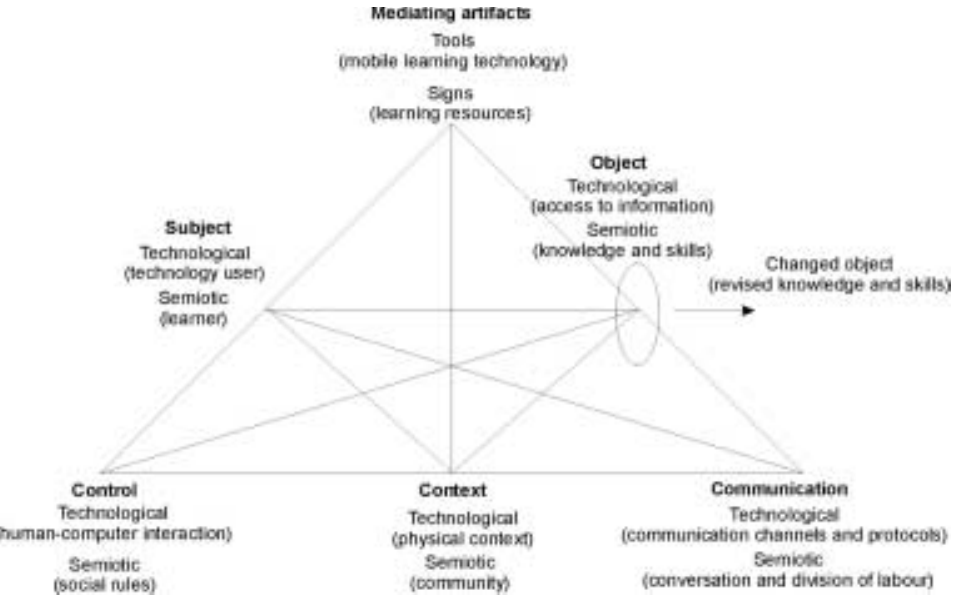
Figure 2. Framework for analysing mobile learning (adapted from Sharples et al.